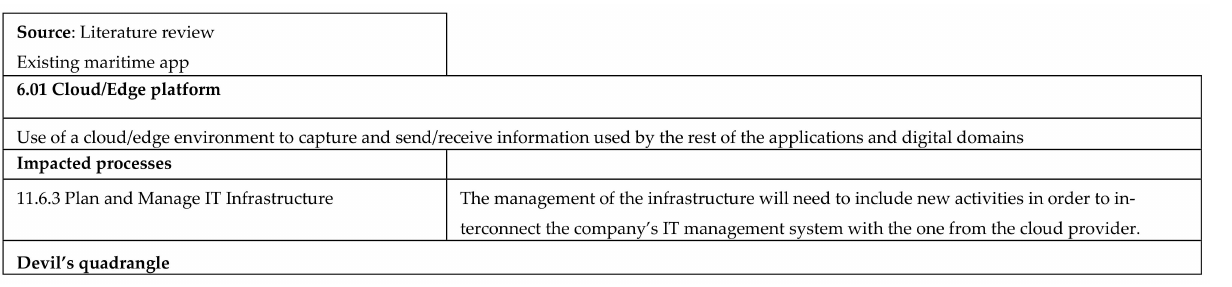
Figure A39. Cont